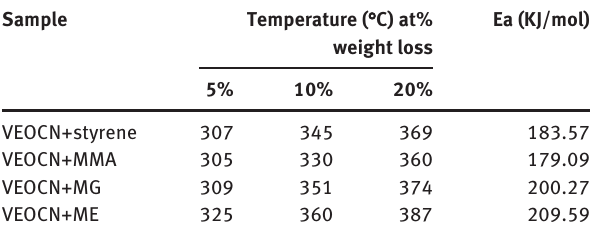
Table 3: Temperature of 1–20% weight loss in TGA and activation energy (E ) of cured VEOCN samples containing styrene, MMA, MG a and ME as reactive monomers, respectively.